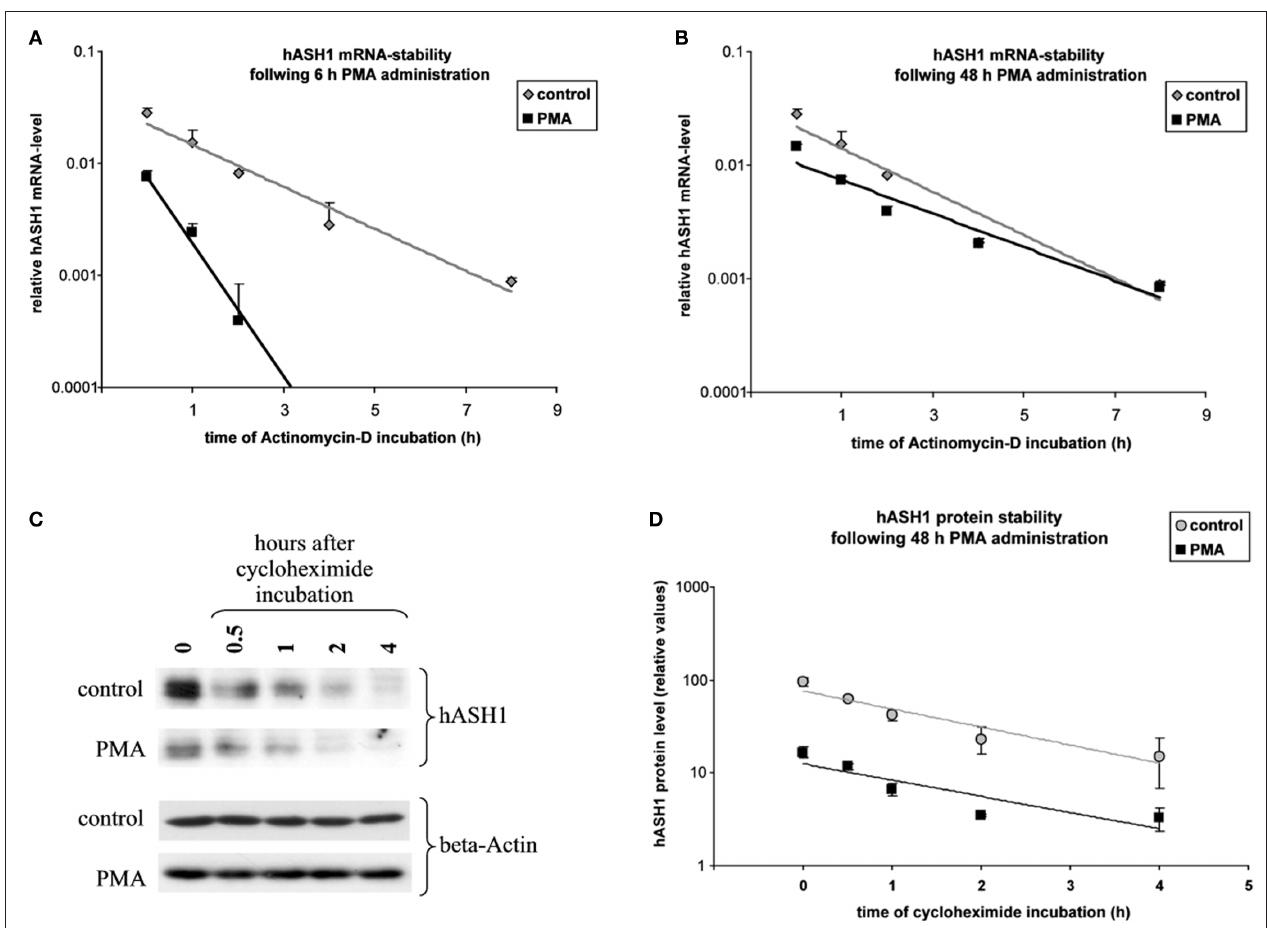
Figure 5 | estimation of hASH1 mrNA and protein half life. Kelly cells were incubated for 6 or 48 h under control conditions or were treated with PMA (40 nM). Following solvent/PMA pre-incubation cell culture media were supplemented with either actinomycin D to assess hASH1 mRNA half life or cycloheximide for the estimation of hASH1 protein stability. (A) hASH1 mRNA stability at 6 h control vs.